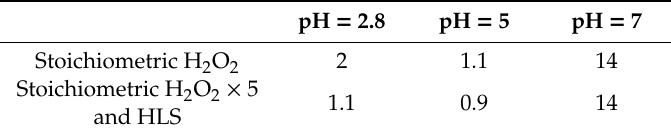
Table 3. Degradation of PCP by photo-Fenton at three di ff erent pH (2.8, 5 and 7) with the